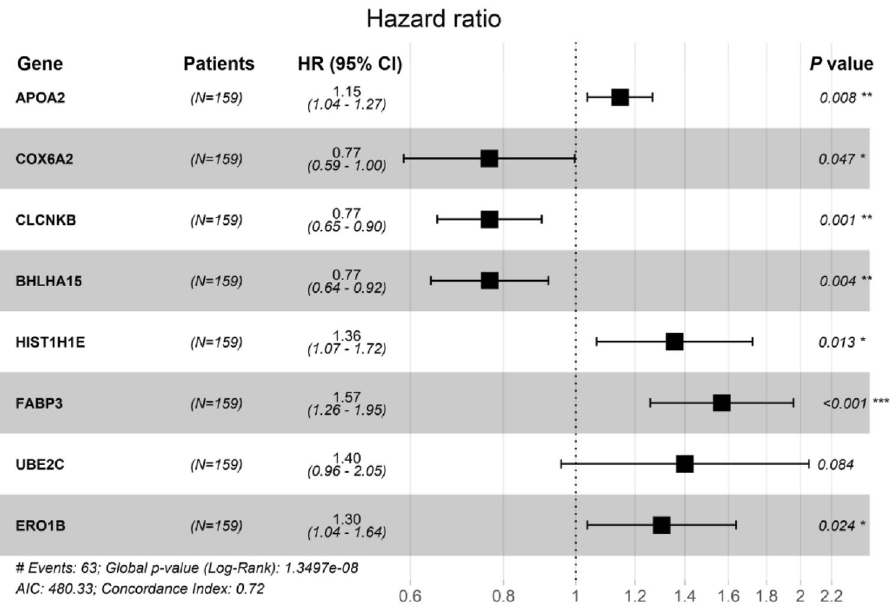
Figure 5. Forest maps of multivariate Cox regression analysis results. HR (Hazard Ratio) represents the risk coefficient of high expression group relative to low expression group. If HR > 1, the gene is a risk factor; If HR < 1, the gene is a protective factor; 95% Cl represents HR confidence interval. * p < 0.05, ** p < 0.01, *** p <